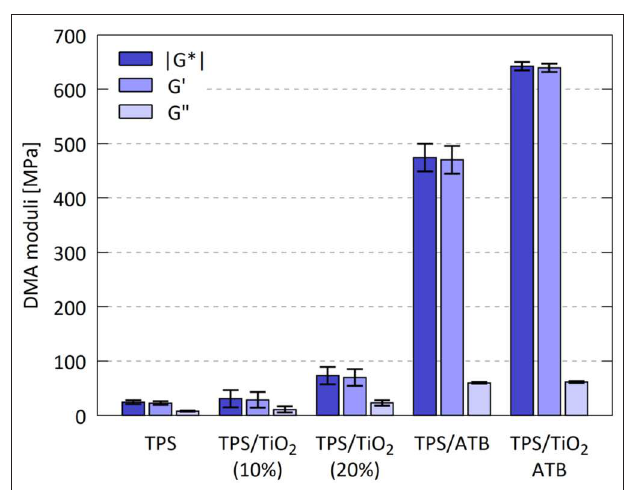
FIGURE 7 | Shear moduli (storage modulus G ′ , loss modulus G ′′ , and complex modulus |G*|) from DMTA analysis of the TPS/TiO 2 /ATB composites, determined at room temperature, angular frequency 1.33 rad/s and strain of 0.1%; error bars represent standard